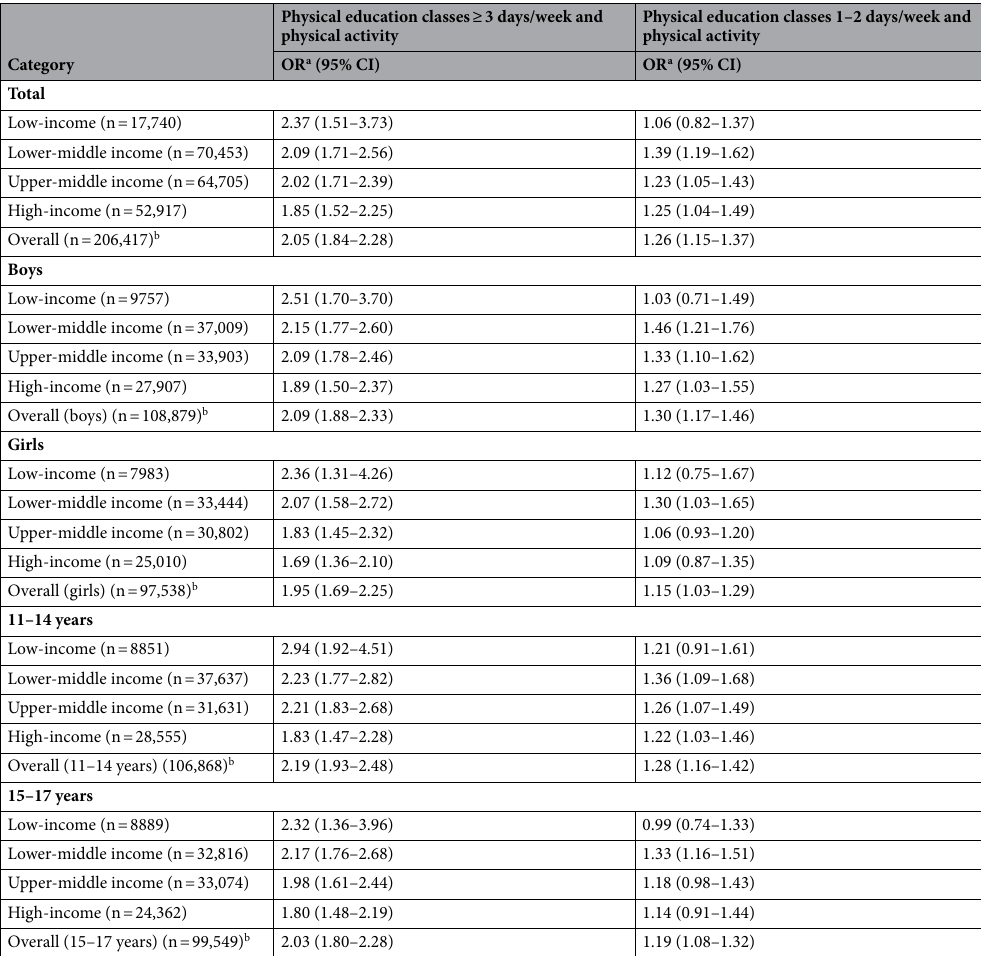
Table 2. Pooled estimates of association between frequency of physical education classes and sufficient physical activity among adolescents aged 11–17 years, by World Bank country income classification , Global School-based Student Health Surveys, 2007–2016. a Reference being attending no physical education class. b Cook Island (n = 602), which was not a part of income classification, was included in calculating the overall pooled estimate. OR odds ratio, CI confidence